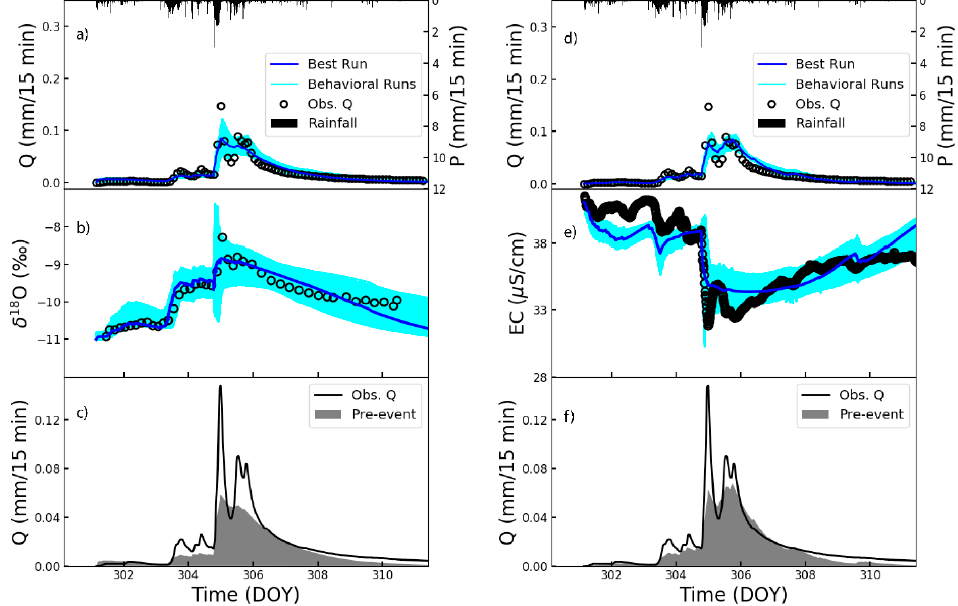
Figure 4. TraSPAN modelling results of the hydrograph separation using structure 1 with δ 18 O ( a – c ) and electrical conductivity (EC) ( d – f ) as tracers for calibration. ( a , b , d , and e ) show the observed (open markers) and simulated streamflow and tracer data according to at least 100 different sets of parameters (light blue lines) yielding Nash-Sutcliffe efficiencies (NSEs) above 0.70 (behavioral parameter sets). The simulated times series with the set of parameters that yielded the highest NSEs are depicted in dark blue lines in all cases. ( c and f ) present the pre-event water (gray shaded area) and the event water (unshaded area) contributions during the storm corresponding to the set of parameters yielding the highest NSEs.